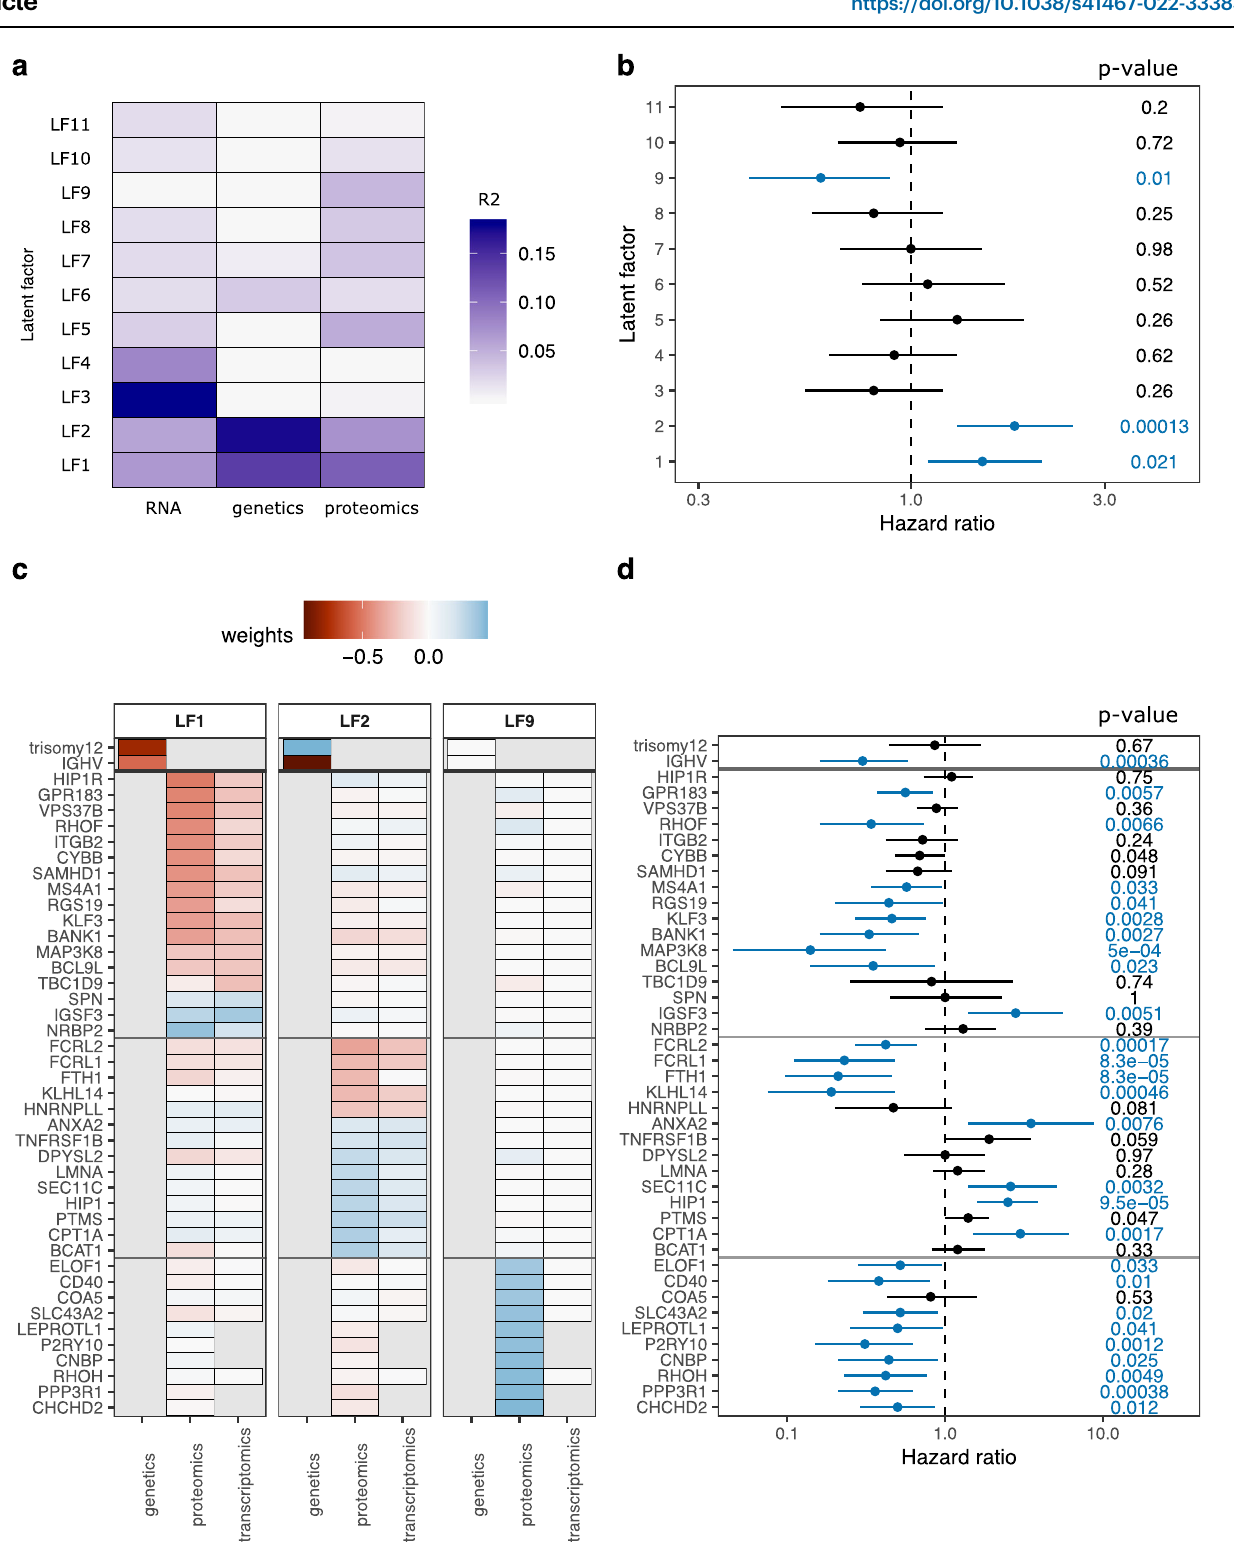
Fig.3|Multi-omicsfactoranalysis(MOFA)ofproteogenomicsdataset.a MOFA of proteome, transcriptome, and genome dataset identi fi ed 11 latent factors (LF) eachexplainingatleast1.5%ofvariance.Explainedvariancesperfactoranddataset are color-coded. b Hazard ratios from Cox regression of LFs with time to next treatment(TTNT).LF1,LF2,andLF9weresigni fi cantly(FDR<10%,blue)associated with TTNT. P values (Wald-test) are shown on the right. Mean and 95% con fi dence intervals are shown. n =61 biologically independent patient samples. c Genes,